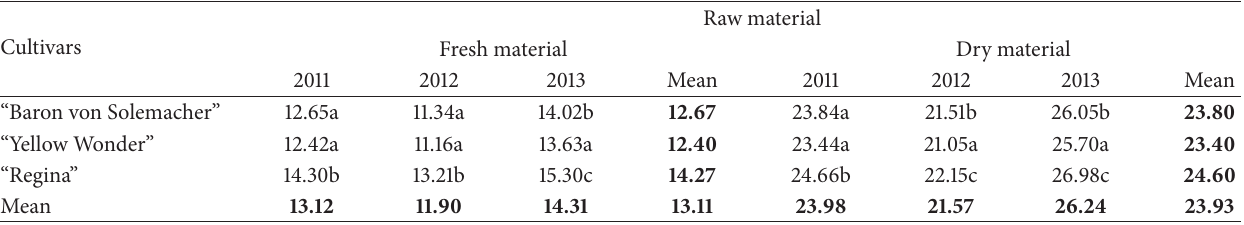
Table 4: Antioxidant activity (%) expressed as the ability to neutralize the DPPH radical in water extracts made of studied materials in successive years of the